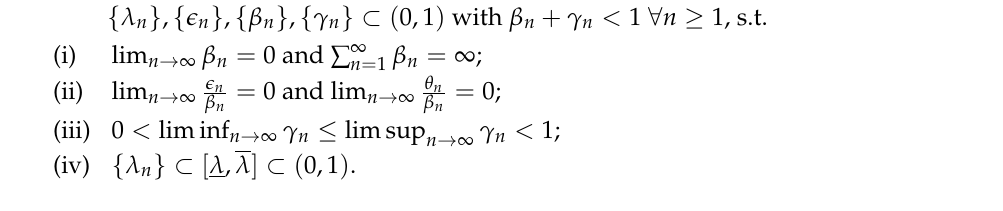
Algorithm 3: Strengthened inertial-type subgradient extragradient